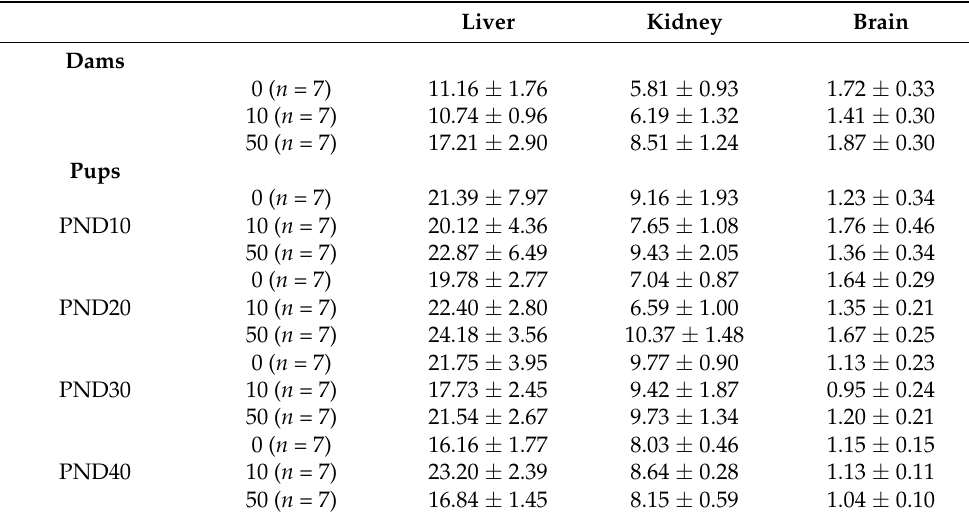
Table 5. Porphobilinogen synthase activity from different organs of dams and pups exposed to different doses (0, 10, and 50 µ g Hg 2+ /mL) of HgCl 2 as described in Tables 1 and 3, respectively. Liver